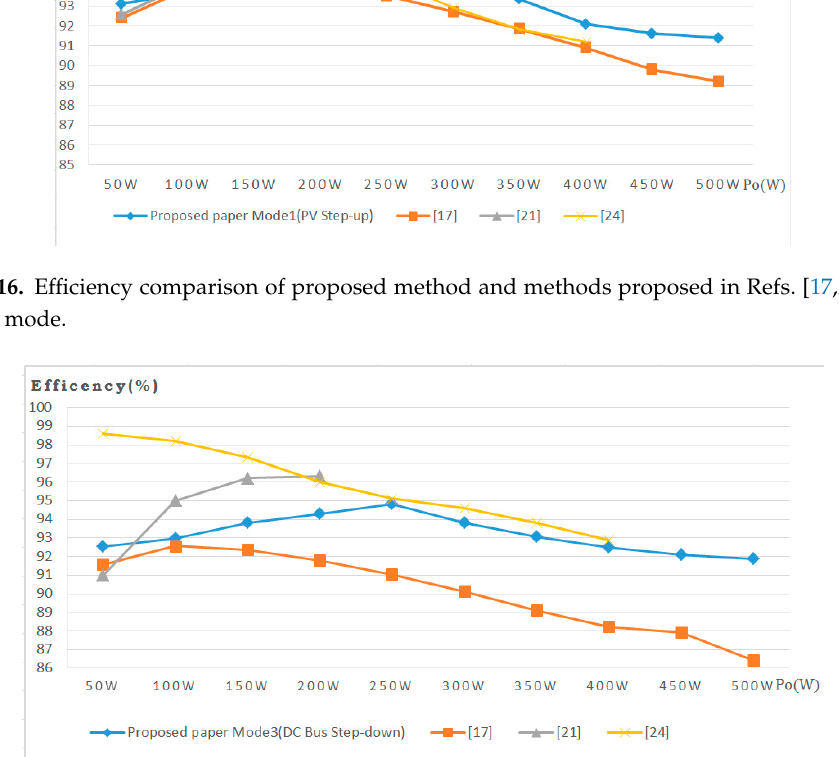
Figure 17. Comparison of efficiency of proposed converter with those of converters proposed in [17,21,22] in step-down mode.